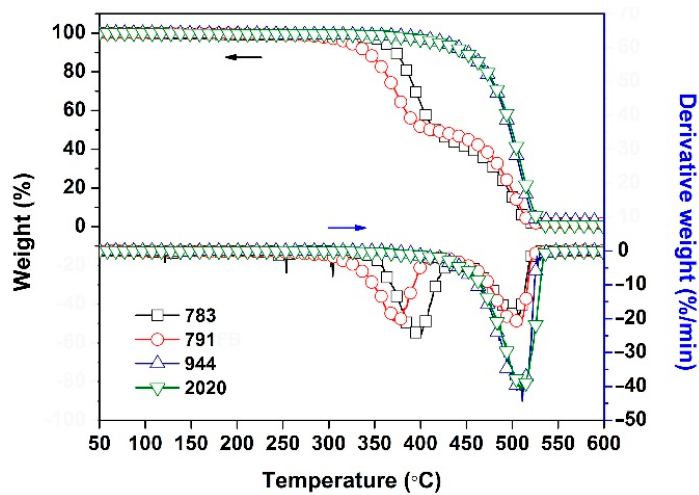
Figure 4. TGA and DTG plots of hindered amine light sensitizers (HALS). Table 3. Thermal stability of the HALS compounds. Table 3. Thermal stability of the HALS compounds. HALS